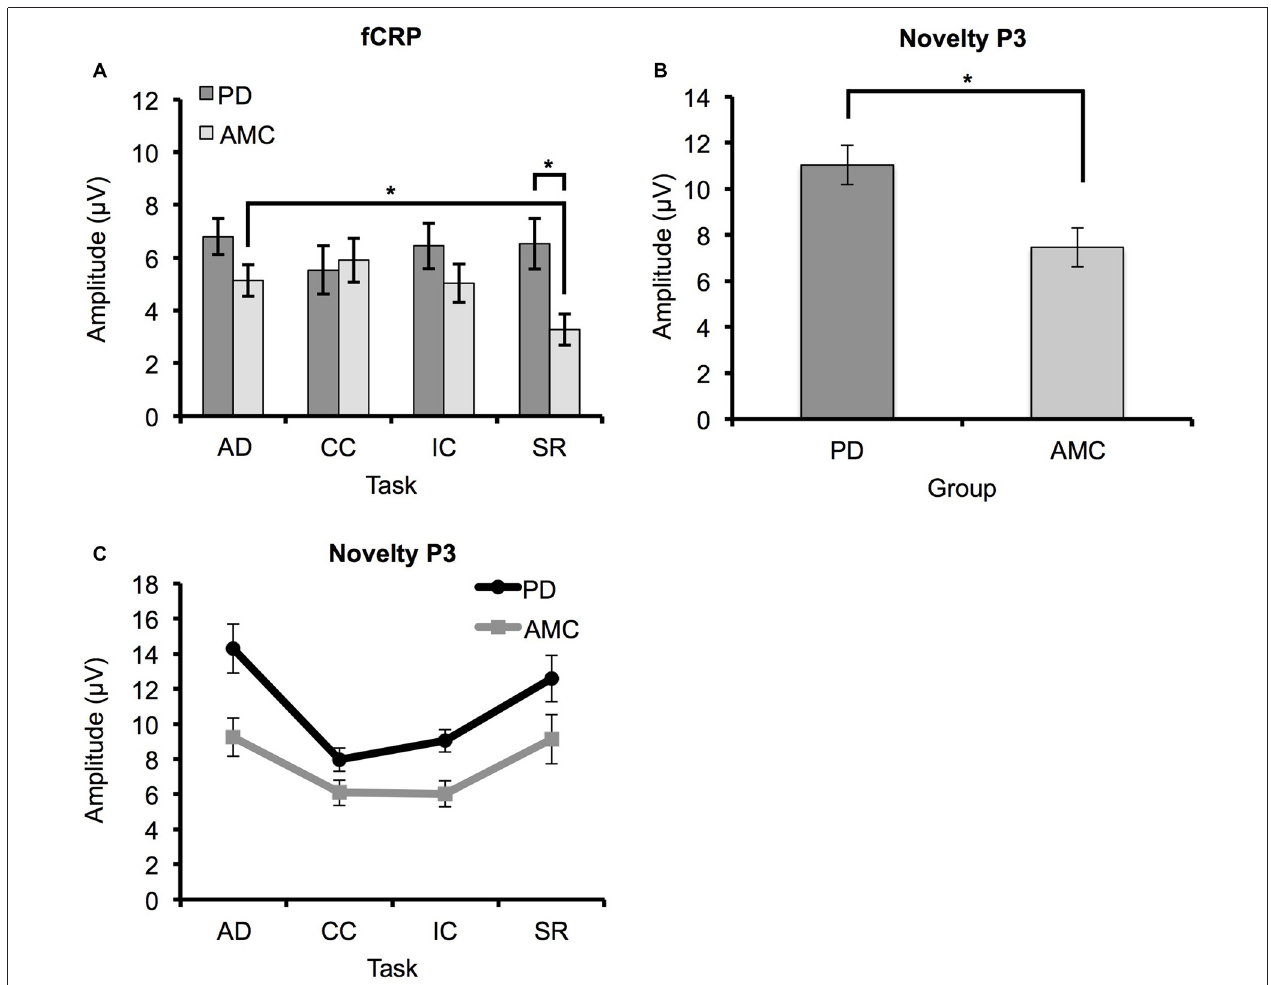
FIGURE 4 | ERP results for PD and AMC groups. (A) Feedback correct-related positivity (fCRP) amplitude in the PD and AMC groups for the AD task, CC task, IC task, and SR task. There was a significant difference in fCRP amplitude between the PD group and the AMC group in SR. For the AMC group, fCRP amplitude in SR was significantly reduced compared to AD. (B) There was an overall significant enhancement in novelty P3 amplitude in the PD group compared to the AMC group. (C) However, the general trend of the novelty P3 was similar across the different tasks for both groups. Error bars indicate standard error. ∗ p <